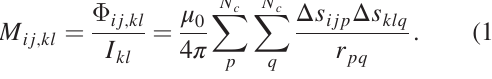
TABLE II. Examples of maximum B 0 and Δ B λ [mm] u